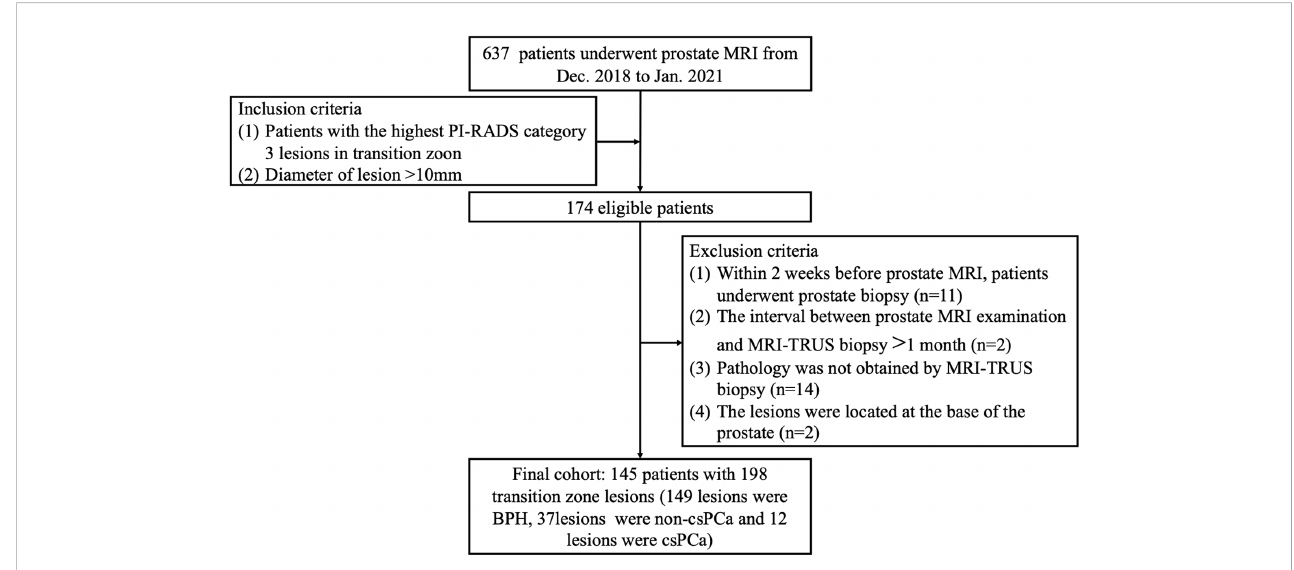
FIGURE 1 Flow diagram of the study